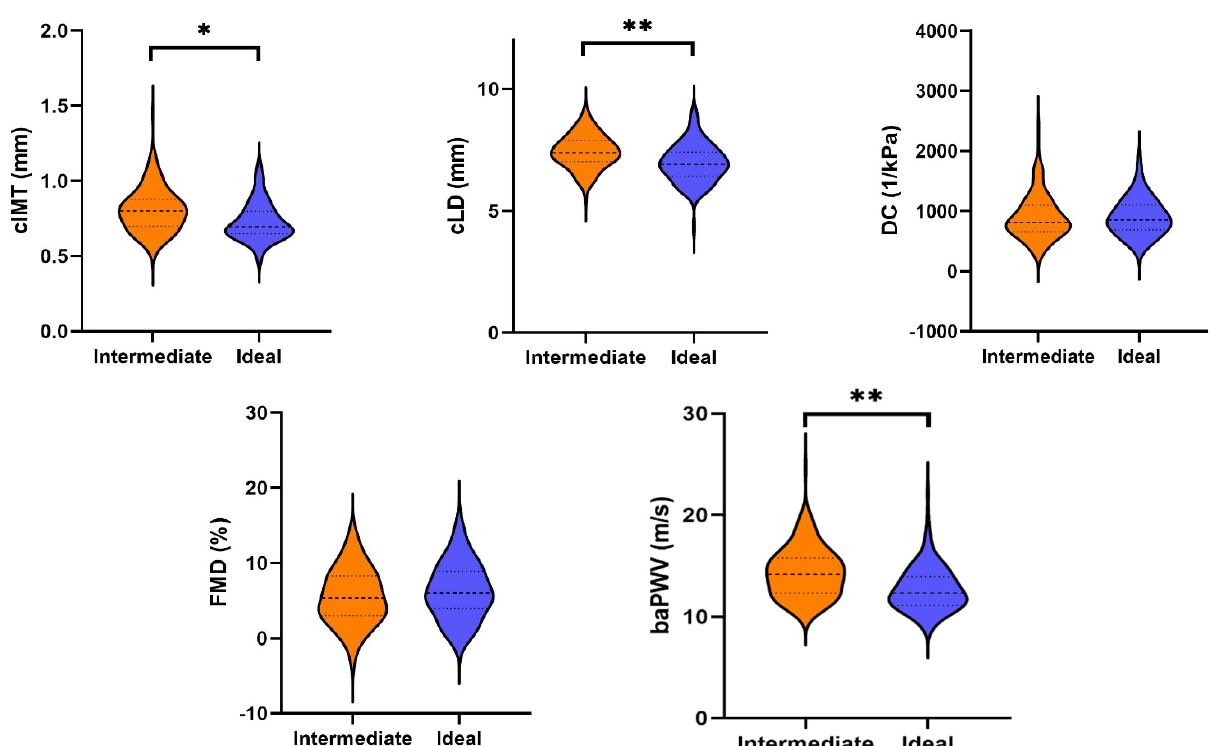
Figure 3. Violin plots of the arterial properties, divided into intermediate and ideal health scores.